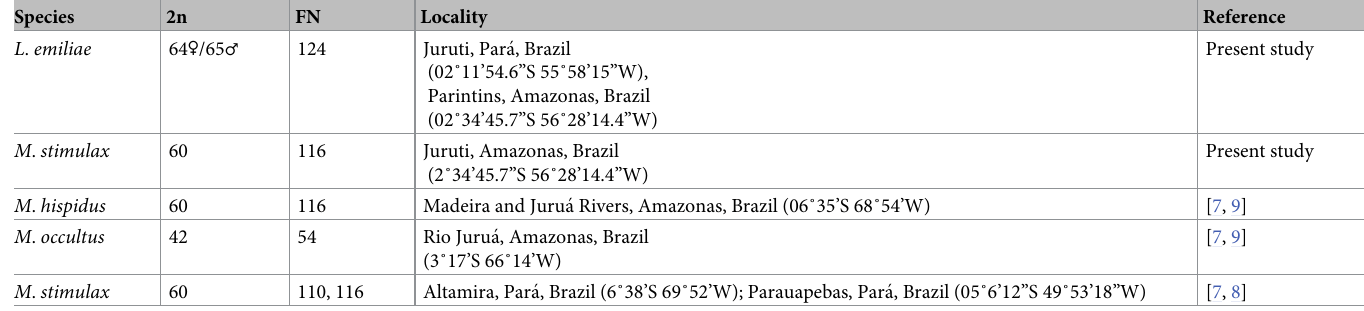
Table 1. Cytogenetic data for the Lonchothrix and Mesomys genera, including the diploid number (2n), the autosomal fundamental number (FN), the locality, and appropriate references. Species 2n FN